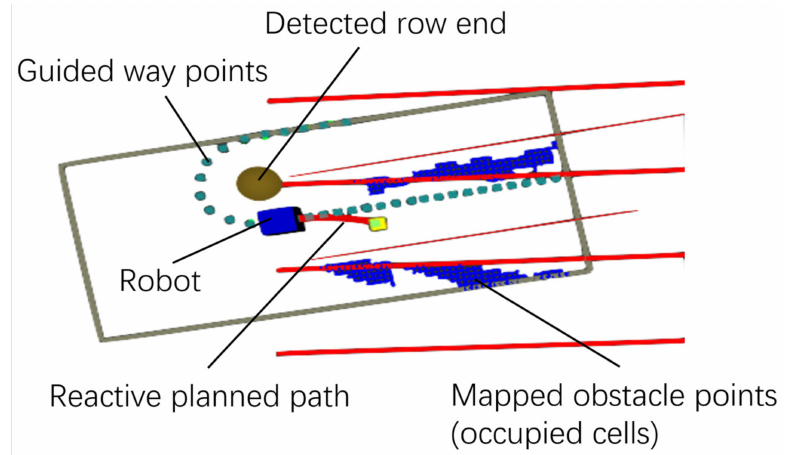
Figure 9. Visualization of markers from ROS-RVIZ visualization package. The brown circle represents the detected end of the row. The cyan-colored dotted line shows the waypoints on the reference path. As the robot (blue box) enters a new row, a drift error would cause it to collide with the vine row to its left if it followed the reference path. In our approach, the robot is guided by a reactive path planner, which generates a path (red curve) that deviates from the reference path and guides the robot into the row, where navigation can rely on template